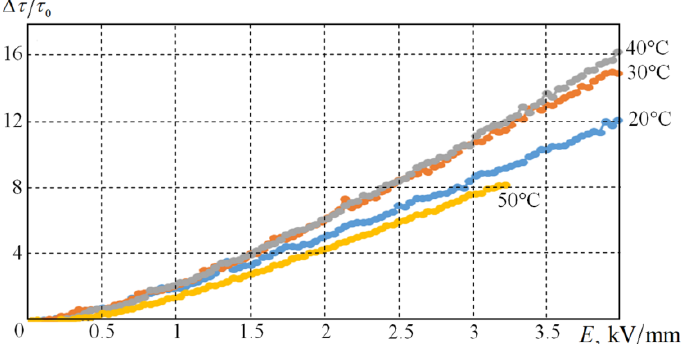
Figure 8. The dependence of the adjusted value of shear stresses on the electric field in temperatures 20, 30, 40, and 50 °C for suspensions of concentration of polyimide PI-Na 10 wt %. At 50 °C and the voltage of ~3 kV / mm, a short circuit occurs in the measuring node, and the current increases abruptly. Apparently, this is due to the presence of sodium ions, which leads to the appearance conductivity in the suspension.